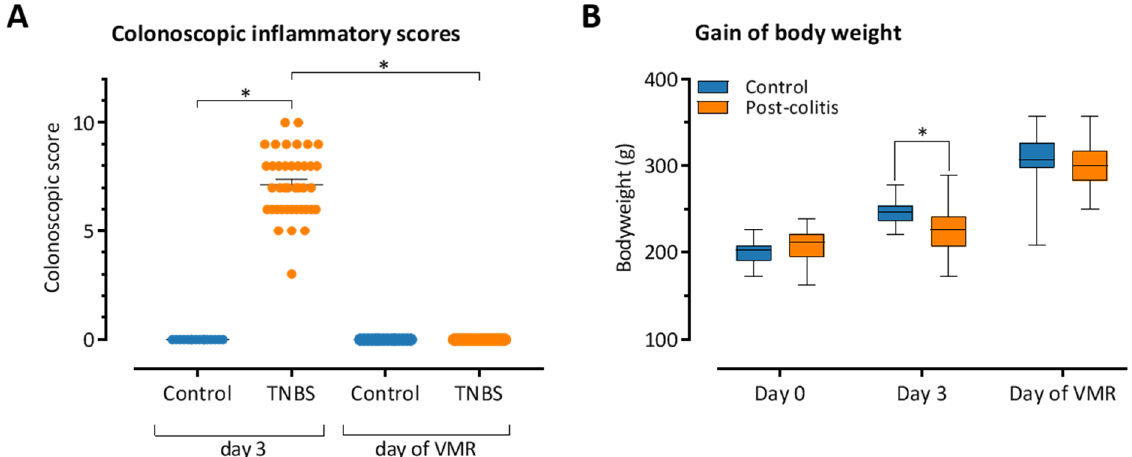
Figure 2. Evaluation of inflammatory parameters in the post-colitis rat model for visceral hypersensitivity. ( A ) Inflammatory colonoscopic scores on day 3 and on the day of the VMR experiments. Data are presented including mean ± SEM. Two-Way ANOVA with ‘treatment’ and ‘group’ factors followed by a Student–Newman–Keuls post hoc test. Significant effect of ‘group’ factor, but not ‘treatment’ factor. No significant interaction between ‘treatment’ and ‘group’; n = 8 per group, treatment groups were combined for visualization. ( B ) Increase in body weight during the experiment. Generalized estimating equations applied using an unstructured working correlation matrix, followed by a least-significant difference (LSD) post hoc test; n = 8 per group, treatment groups were combined for visualization. Note: * p < 0.05; significantly different.